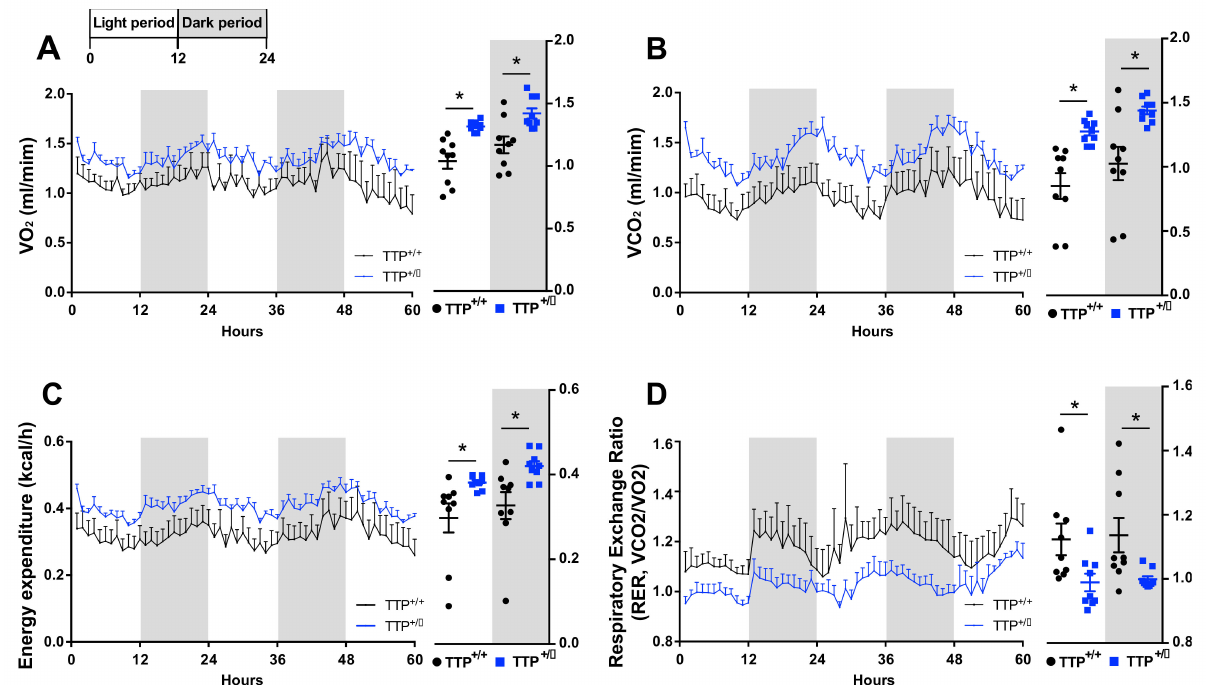
Figure 7. TTP-deficient mice display increased energy expenditure and lipid utilization. Metabolic phenotypes that reflect energy expenditure were determined using an indirect calorimetry instrument. ( A ) Increased oxygen consumption (VO 2 ), ( B ) carbon dioxide generation (VCO 2 ), and ( C ) energy expenditure were observed in TTP-deficient mice compared to that in wild-type mice. ( D ) Respiratory exchange ratio (RER) was decreased in the TTP-deficient mice compared to that in wild-type mice. Data are presented as the mean ± SEM. n = 9 mice per group. * p < 0.05. SEM; standard error of the